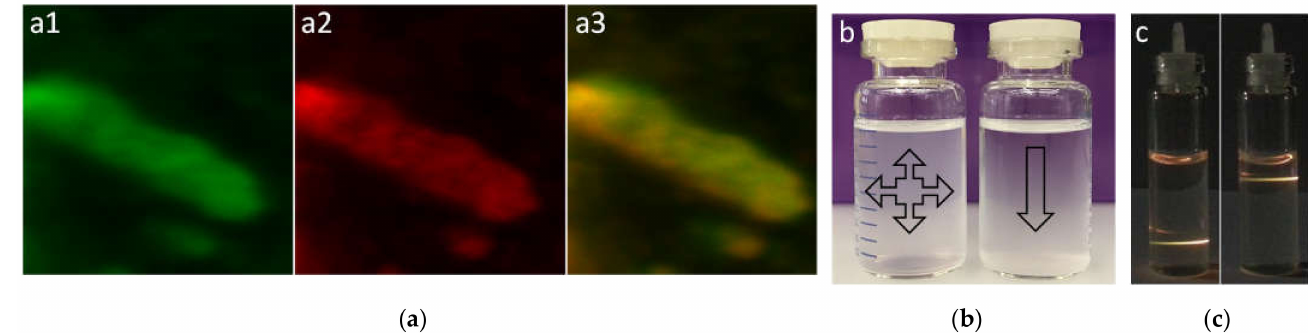
Figure 2. ( a ) Confocal imaging of as-synthesized β -UCNPs under 980 nm excitation by Multiphoton Leica SP8 equipped with NIR laser ( a1 ) green and ( a2 ) red channels; ( a3 ) the merge of two channels. ( b ) Photography of surface-polished with HCl (right bottle) and PAMAM surface-modified (left bottle) UCNPs dispersed in water. Precipitation of UCNPs without PAMAM started relatively fast after suspension but PAMAM might keep the solubility of UCNPs up to a few days depending on the level of coated polymer around the NPs. ( c ) Photography of excited UCNPs-PAMAM by a 980 nm laser pen after suspension in water that shows high water-solubility and homogenous dispersity of UCNPs. The impact of hydroxyl groups from water and organic polymer coat around the particles influenced the luminescence of UCNPs by decreasing the ratio of green against red